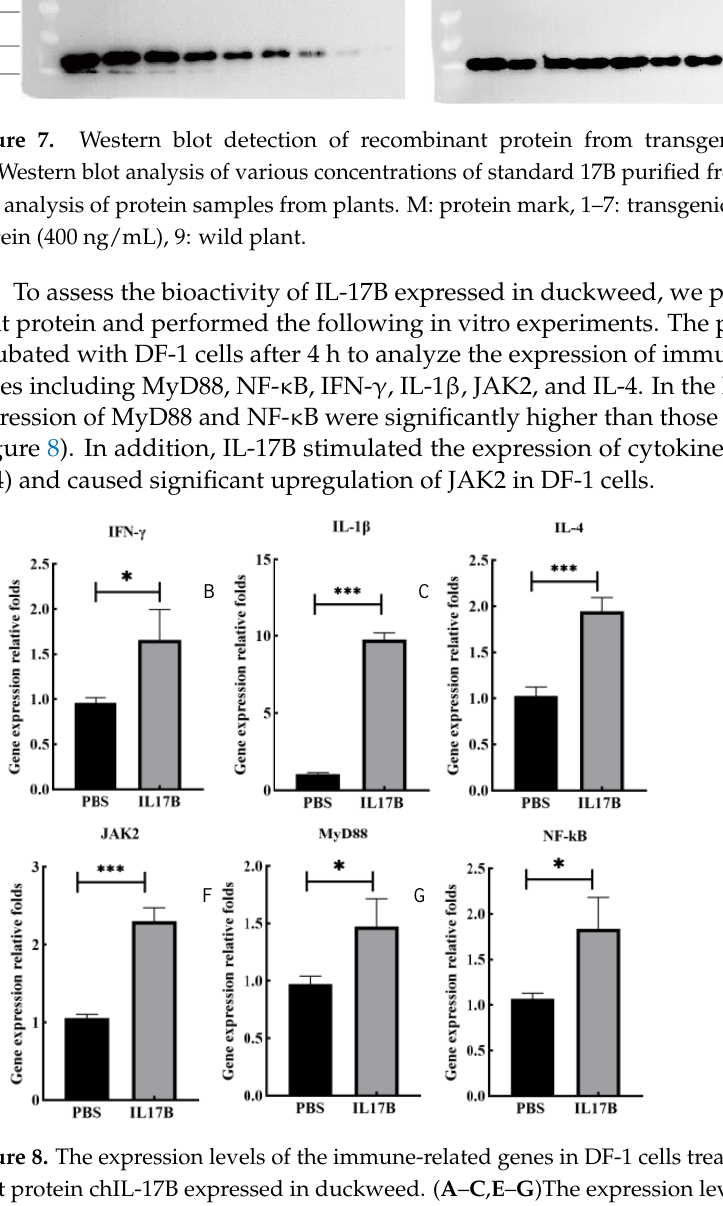
Figure 6. Molecular validation of transgenic lines with 17B specific primers. M: DNA mark, 1~22: transgenic lines, W: wild plant as negative control, P: p2301-17B plasmid as positive control.